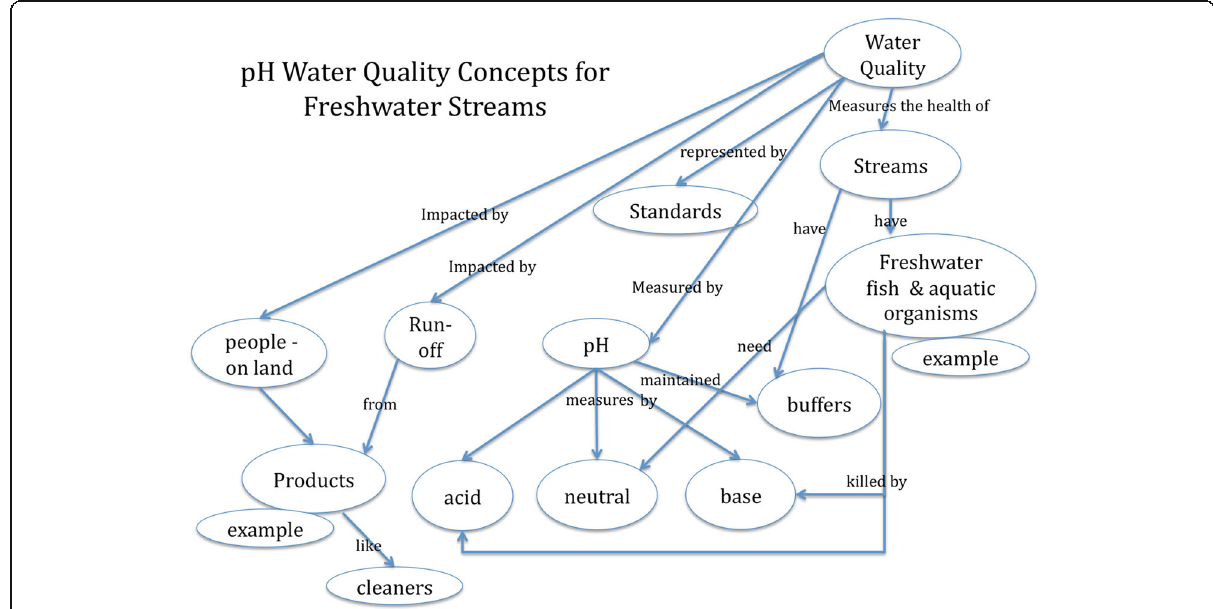
Fig. 1 pH portion of Water Quality Concept Map